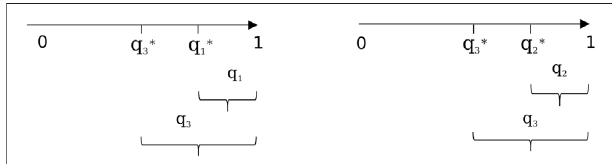
FIGURE 3 | Interval relationship of implementation probability of three policies which was greater than the equilibrium